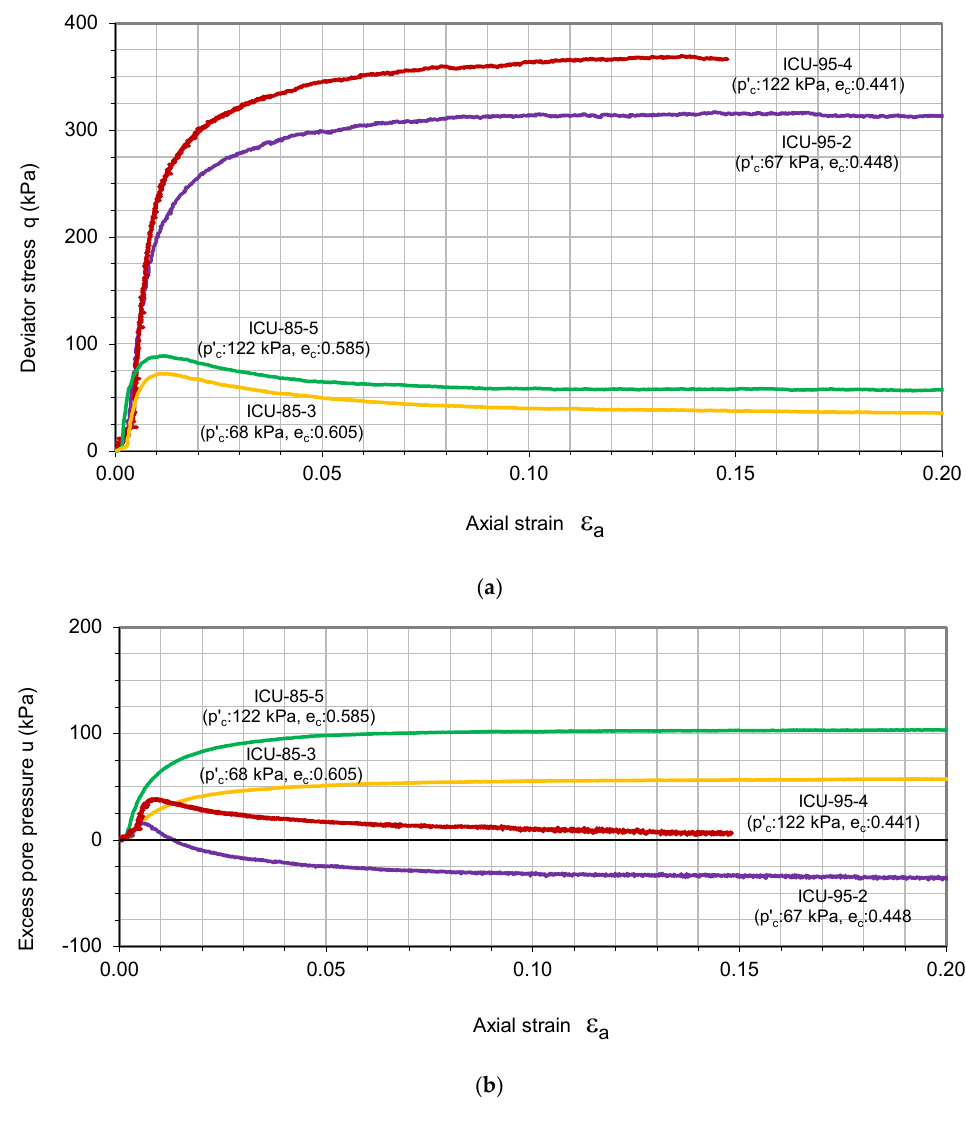
Figure 3. Results of the ICU tests on the residual soil: ( a ) q against ε a ; ( b ) u against ε a . Table 4. Comparison of index and steady-state parameters of residual